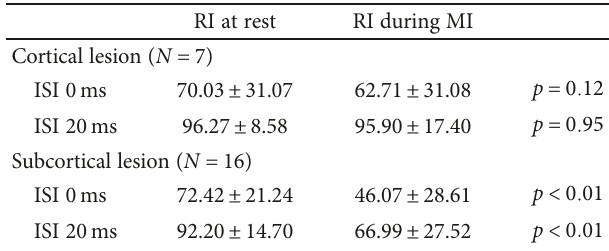
Figure 2: Correlation between the motor imagery e ff ect score on reciprocal inhibition and motor function in the a ff ected upper extremity. With a conditioning test interstimulus interval (ISI) of both 0 and 20ms, no signi fi cant correlation was found between the motor imagery (MI) e ff ect score on reciprocal inhibition (RI) or the motor function in the a ff ected upper extremity as assessed with the Fugl-Meyer Assessment (FMA). Table 3: Reciprocal inhibition at rest and during motor imagery in the two groups according to stroke